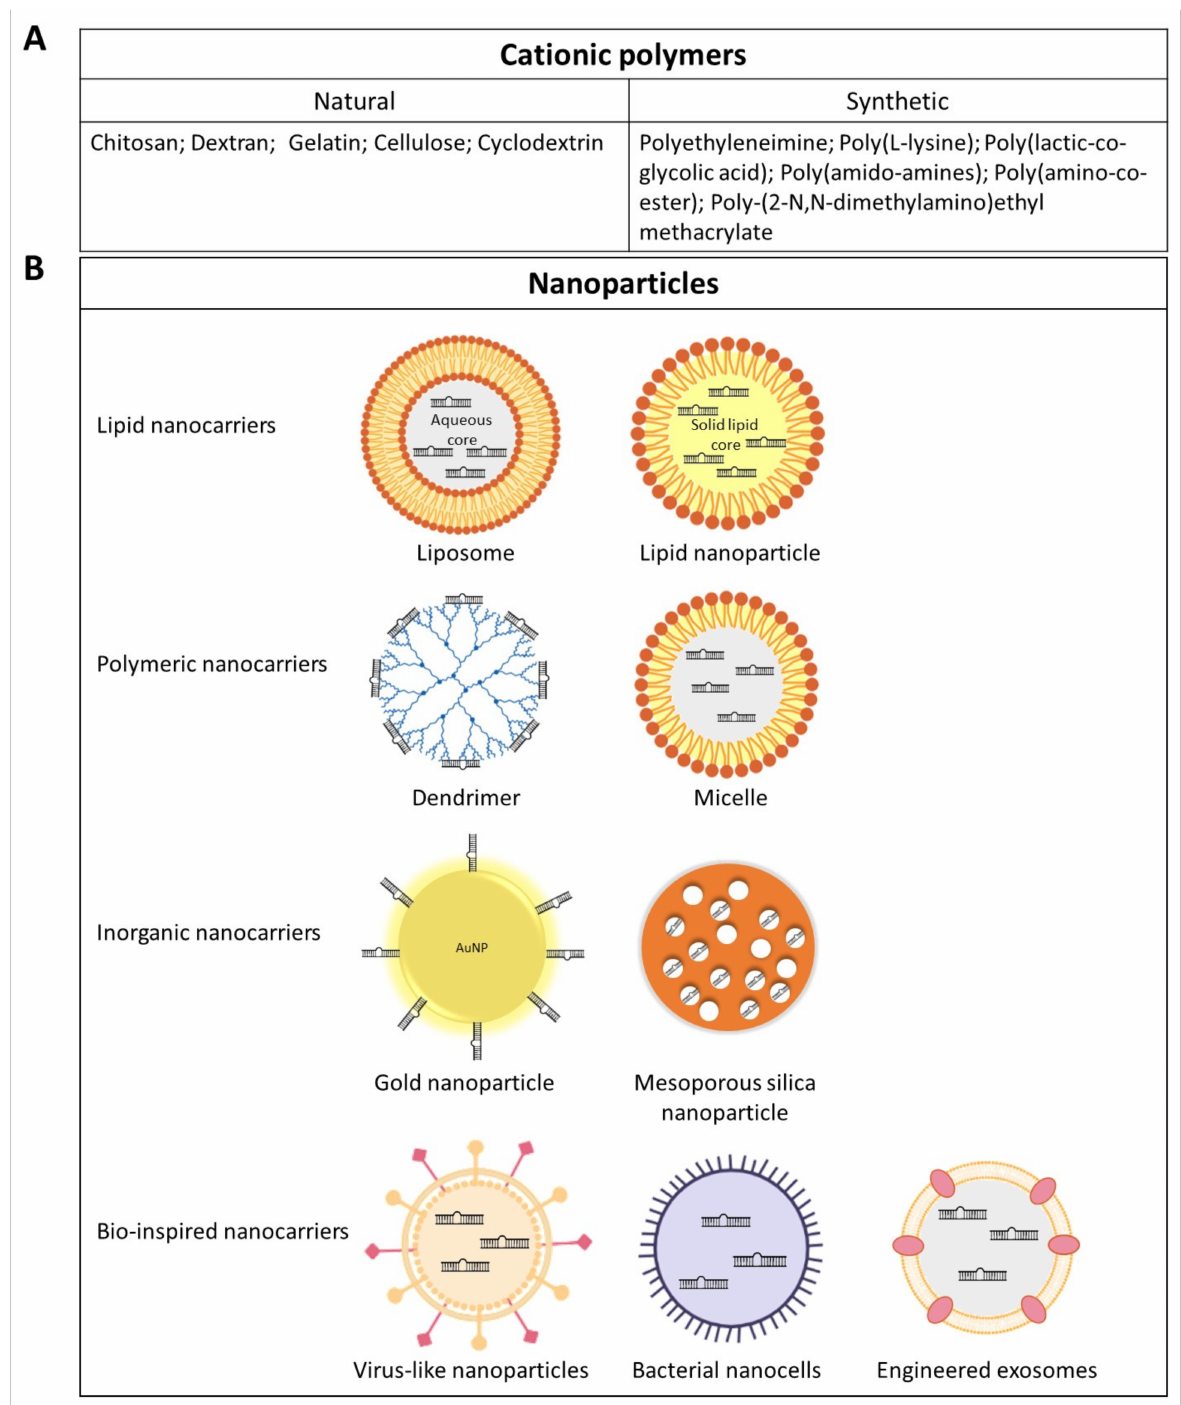
Figure 2. Schematic representation of commonly used and emerging nanoplatforms for miRNA delivery. ( A ) Natural and synthetic polymers can form electrostatic complexes with nucleic acids such as miRNAs. ( B ) Nanoparticle-based platforms are characterized by tunable size, shape, and surface characteristics, which enable them to have compatibility with different administration routes. Specific recognition molecules such as antibodies or peptides can be grafted to target tissues more specifically. Tumor-derived exosomes are being increasingly explored as delivery systems in cancer research since their identification as drivers of organotropic metastatic spread. However, their complex composition and still non-established biological functions led to the development of Exosome-Mimetic Nanosystems that recapitulate natural exosomes structure with a controlled